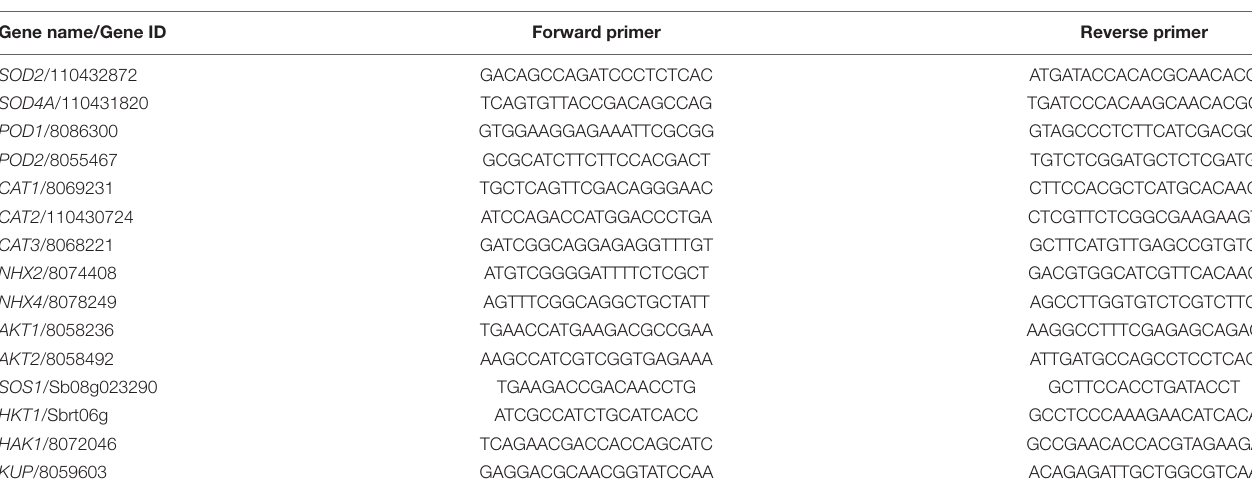
TABLE 1 | Primer used for qRT-PCR